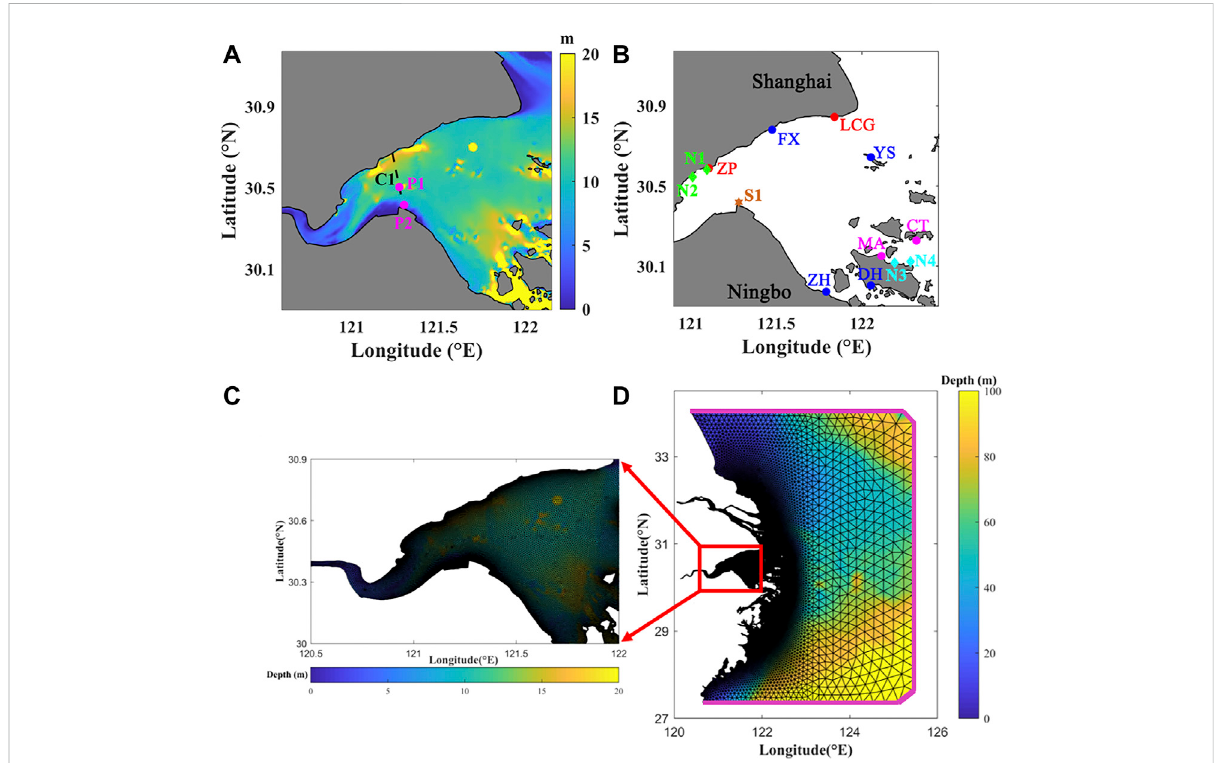
FIGURE 1 (A) Map of Hangzhou Bay. The color indicates water depth. (B) Field stations. LCG is Luchaogang, ZP is Zhapu, GP is Ganpu, MA is Maao, CT is Changtu, FX is Fengxian, YS is Yangshan, ZH is Zhenhai, and DH is Dinghai. Circles indicate tidal stations and diamonds indicate current and SSC stations. (C) Grids of Hangzhou Bay. (D) Grids of study area. Pink lines represent the oceanic boundaries.